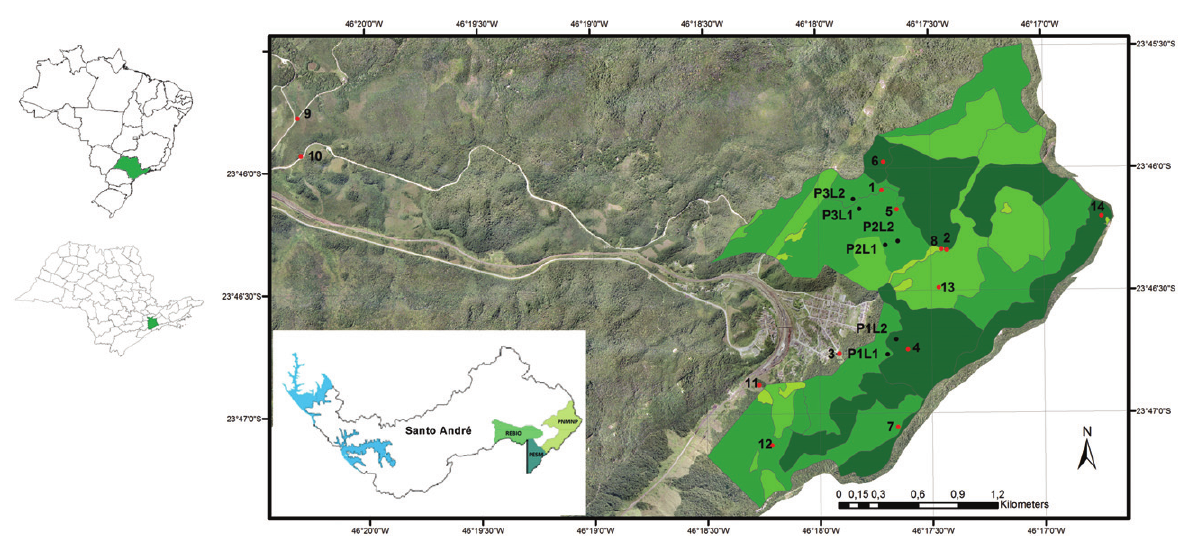
Figure 1. Geographic position of the study area within the state of São Paulo and the municipality of Santo André, including adjacent conservation units. PNMNP: Parque Natural Municipal Nascentes de Paranapiacaba, PESM: Parque Estadual da Serra do Mar, REBIO: Reserva Biológica do Alto da Serra de Paranapiacaba (Adapted from PMSA 2008). Red dots, numbered from 1 to 13, represent localities of visual survey samples, black dots represent localities of pitfall trap samples (P1, P2 and